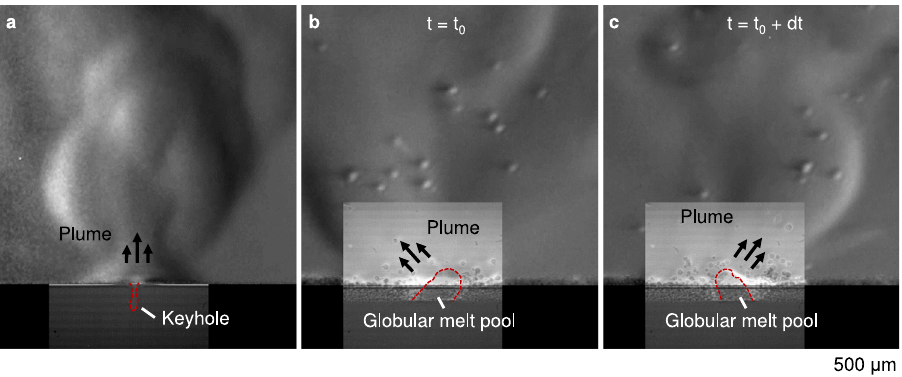
Fig. 9 Comparison of laser-material interaction at low power. Composite images of keyhole and plume ( a ) without and ( b , c ) with powder under 1.3 MW cm − 2 laser power density ( P = 72 W and d = 84 µ m). The introduction of powder prevents the evolution of the depression into a keyhole.